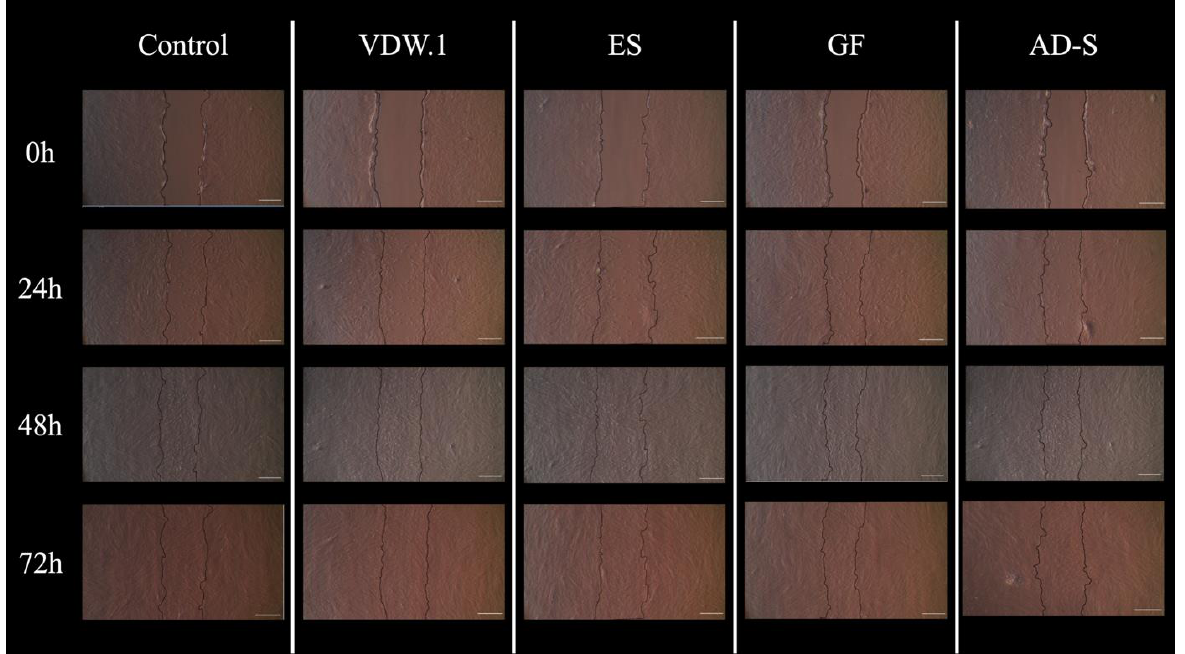
Figure 4. Images of the scratch healing of all groups acquired at 0, 24, 48, and 72 h with a phase- contrast microscope (TCM 400) at magnification of 40 × . Cell migration area was calculated using Image J software and wound closure percentage was calculated for each well.